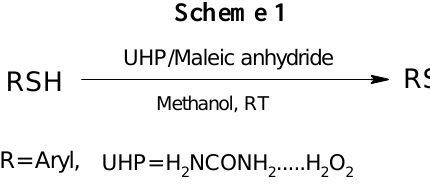
Table 2. Oxidative coupling of thiols using UHP/Maleic anhydride system in methanol at 0 o C Run Thiols Disulfides